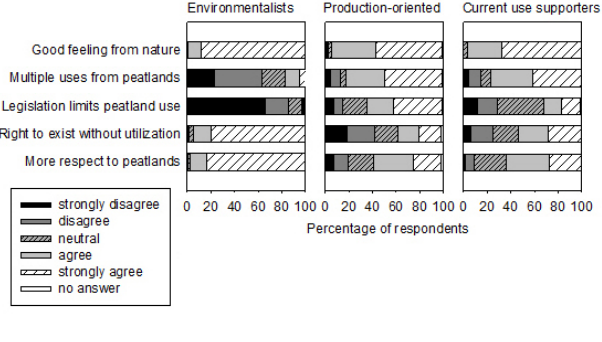
Fig. 4 . Opinions on the significance of nature and peatlands in the three classes of respondents, significant in the latent class model (LCM). Number of respondents =